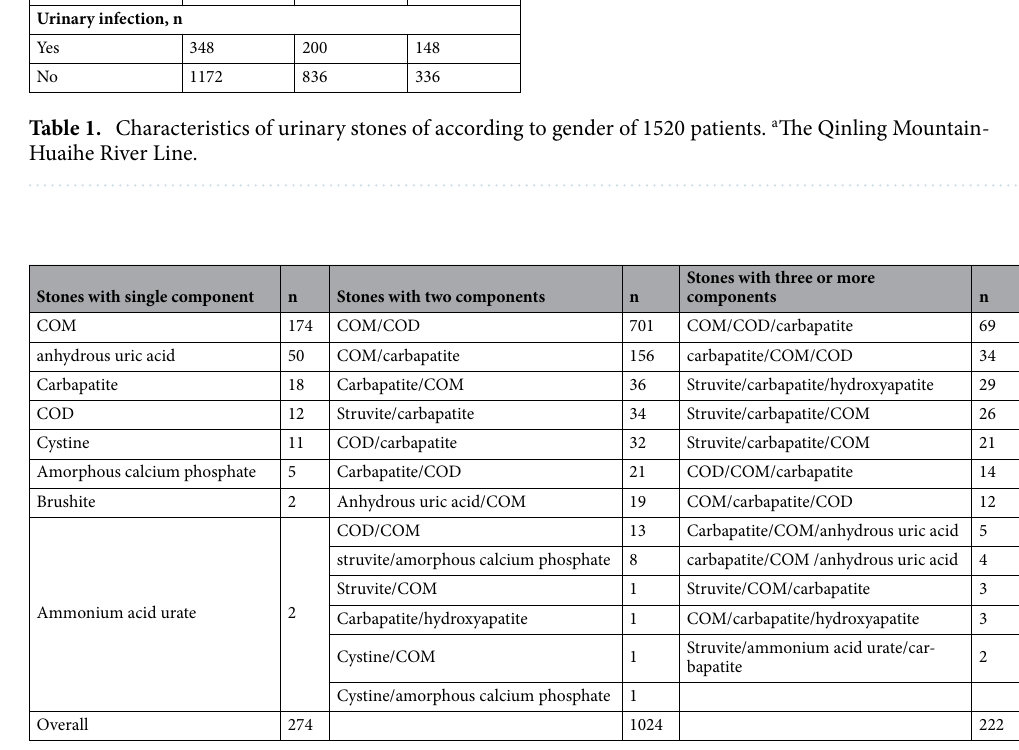
Table 2. The distribution of stones composed of single or multiple components. COM calcium oxalate monohydrate, COD calcium oxalate dihydrate.